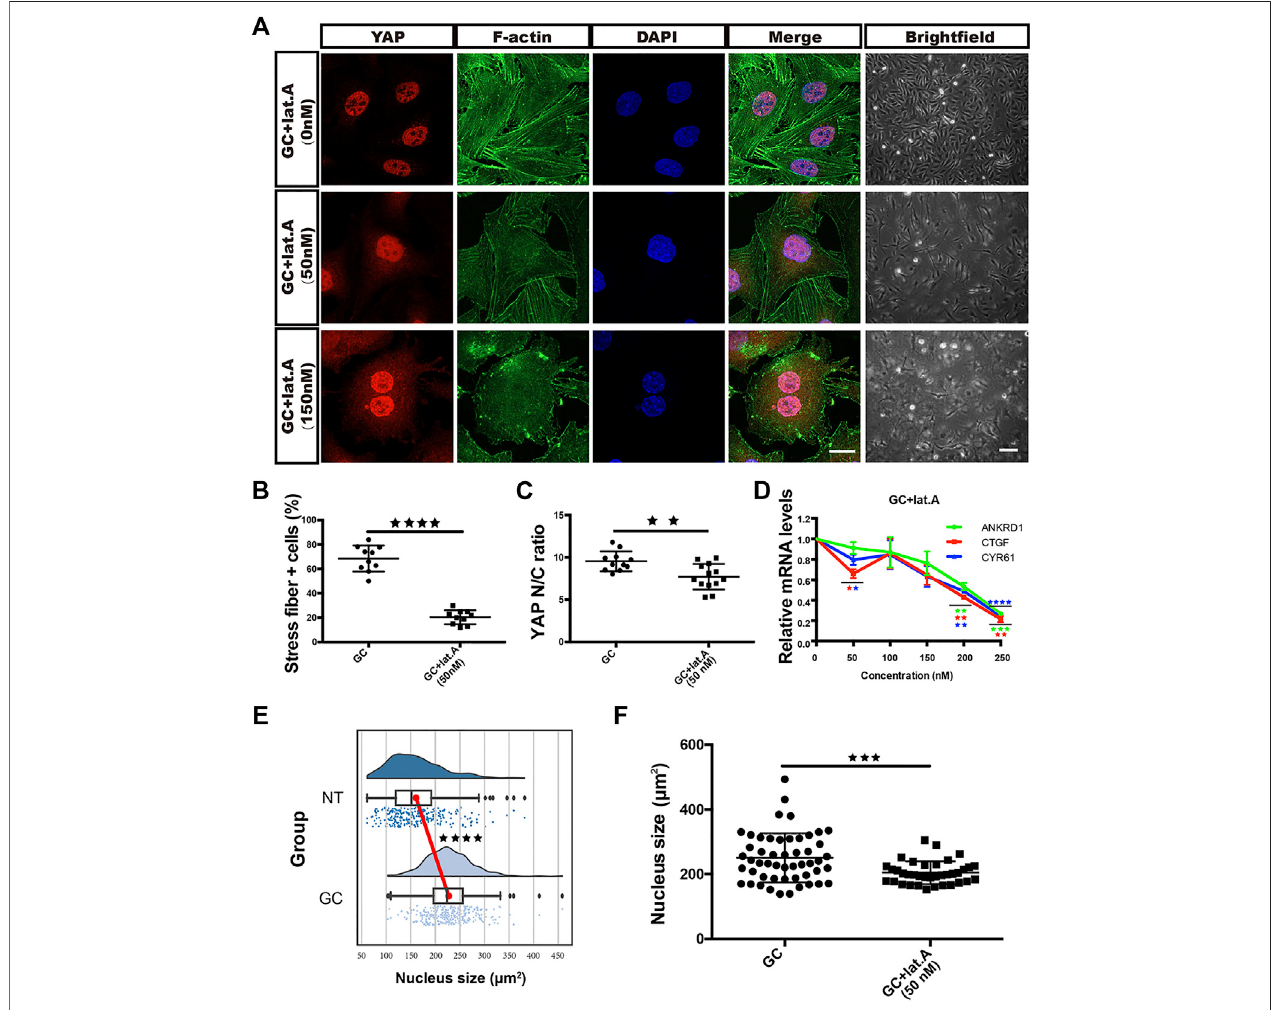
FIGURE 4 | GCs induce YAP nuclear translocation via stress fi ber formation-dependent fl attening of the nucleus. (A) : YAP/F-actin/DAPI immuno fl uorescence staining of HRCECs treated with 0.8 μ M hydrocortisone alone or in combination with 50 nM or 150 nM lat.A for 72 h. Scale bars, 20 μ m. Bright fi eld microscopy images of HRCECs treated under the indicated condition. Scale bars, 200 μ m. (B) : Quanti fi cation of the percentage of cells displaying actin stress fi bers for the three treatment conditions in (A) . (C) : Quanti fi cation ofthe ratioofthe average immuno fl uorescence intensityofYAPbetweenthe nucleus and thecytoplasm ofthecells in (A) . (D) : Real-time qPCR analysis of HRCECs treated with 0.8 μ M hydrocortisone alone or in combination with 50 nM, 100 nM, 150 nM, 200 nM or 250 nM lat.A for 72 h. The mRNA levels of ANKRD1/CYR61/CTGF (targets of YAP) were calculated. (E) : Quanti fi cation of the nucleus size of HRCECs form NT and GC group via immuno fl uorescenceimages. (F) :Quanti fi cationofthenucleussizeofHRCECstreated asin (A) fromimmuno fl uorescenceimages. Theerrorbars represent themean ± SD (B,C,D,F) .TheTukeymethodwasusedtoplotthewhiskersandoutliers (E) ,andtheexperimentwasbiologicallyrepeatedthreetimes.** p < 0.01;*** p < 0.001;*** p < 0.0001. Student ’ s two-tailed unpaired t-test (B,C,E,F) or one-way ANOVA followed by Dunnett ’ s multiple comparison tests (D) . lat.A latrunculin A.